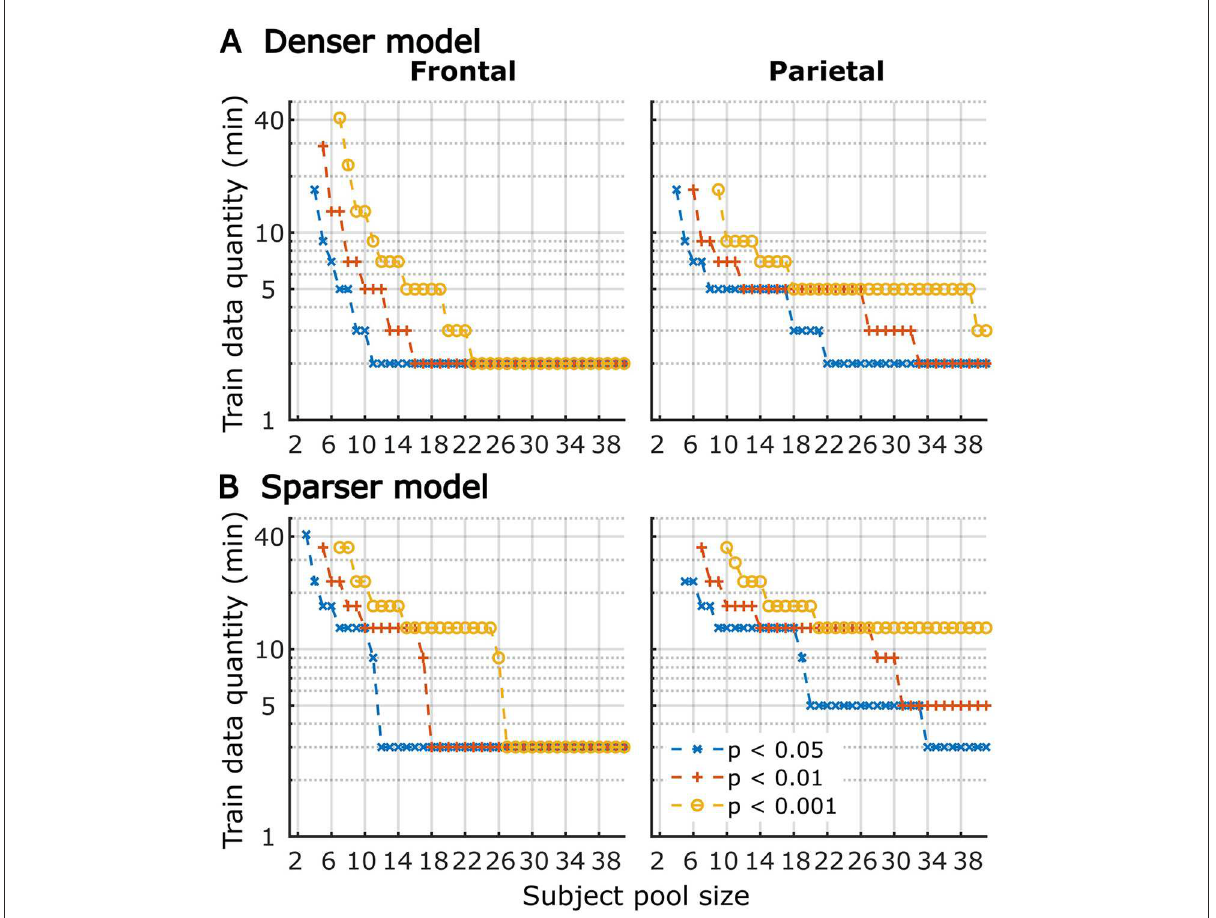
FIGURE7 The amount of training data per participant required to reach significant overall prediction accuracy as a function of participant sample size for the denser (A) and sparser (B) TRF models in frontal (left column) and parietal (right column) ROIs. Different line colors represent different significance levels (see legend in lower right). For visualization purposes, minutes of data are shown on a log axis. The discrete steps along the y-axis stem from the fact that subject-specific analyses were run using 11 discrete data quantities per subject, the results of which were used in this resampling analysis. Therefore, values on the plots represent approximate threshold data quantities needed for each sample